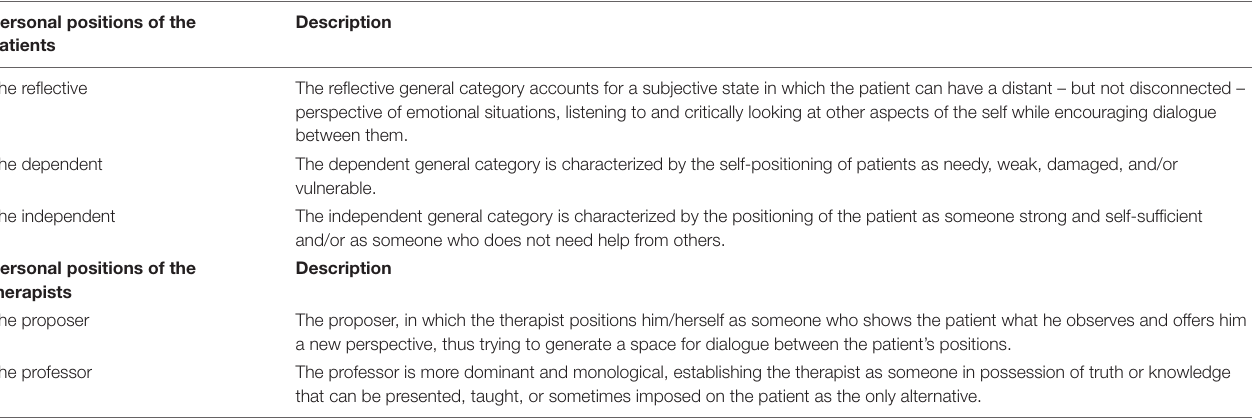
TABLE 2 | Personal positions according to Model of Analysis of Discursive Positioning in Psychotherapy (MAPP) taxonomy (taken from Martínez and Tomicic, 2019). Personal positions of the